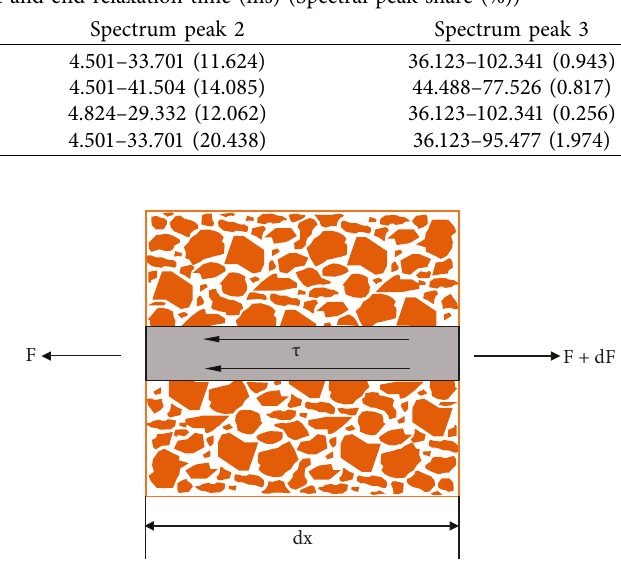
Figure 18: Force diagram of a microelement